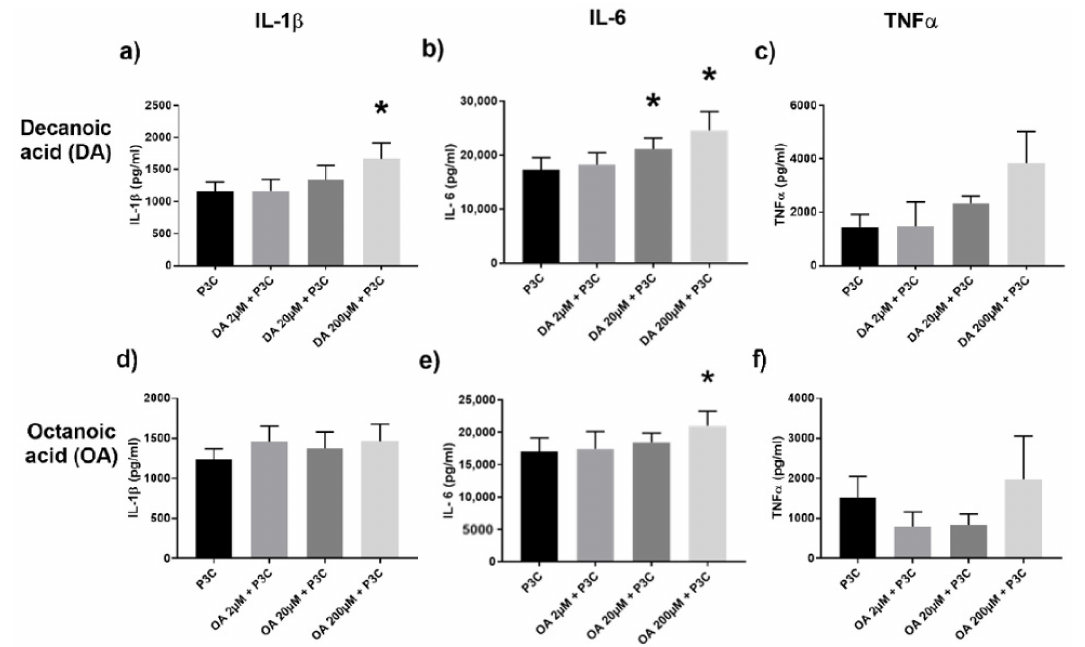
Figure 2. Cytokine IL-1 β , IL-6, and TNF α production in the supernatants of PBMC stimulated with P3C and 2, 20, 200 µ M of decanoic acid (DA) ( a – c ), and octanoic acid (OA) ( d – f ). Values are presented as mean ± SEM, results from at least 7 subjects were used. Wilcoxon signed rank test was used to determine significance for pair-wise comparisons with the control, * p < 0.05 is the cytokine level difference compared to the control P3C group (black